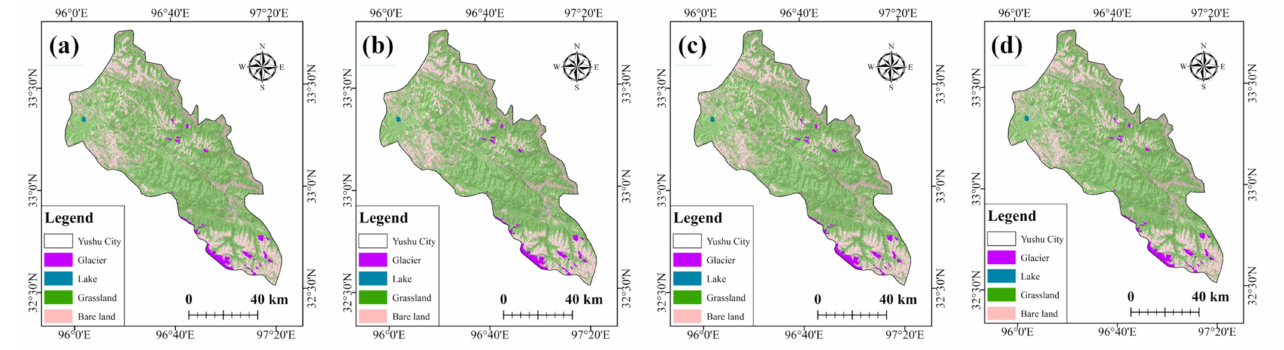
Figure 10. The changes in the eco-environment elements in Yushu City. ( a ) 2015; ( b ) 2017; ( c ) 2019; ( d ) 2021.